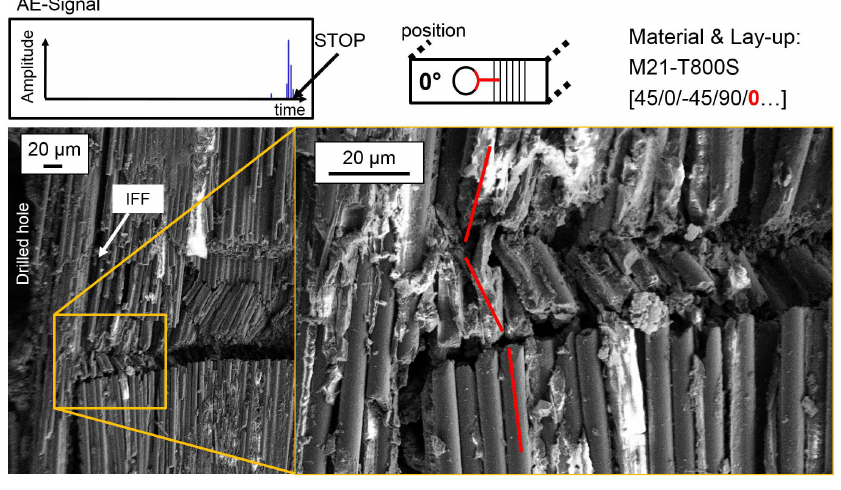
Figure 12. Damage propagation in the inner 0°-layer at the hole in a representative M21-T800S